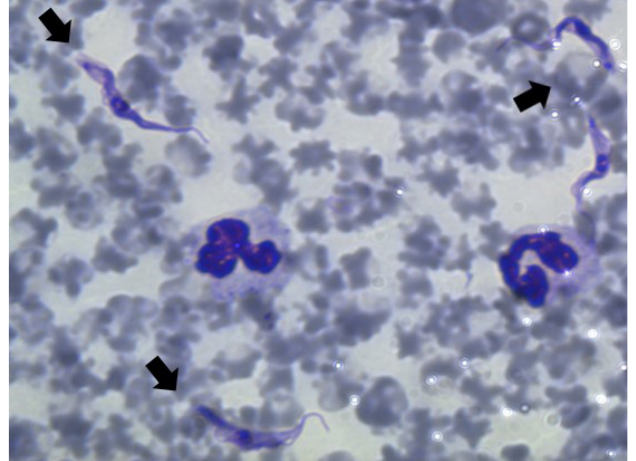
Figure 2. Trypanosoma vivax , viewed on a blood smear